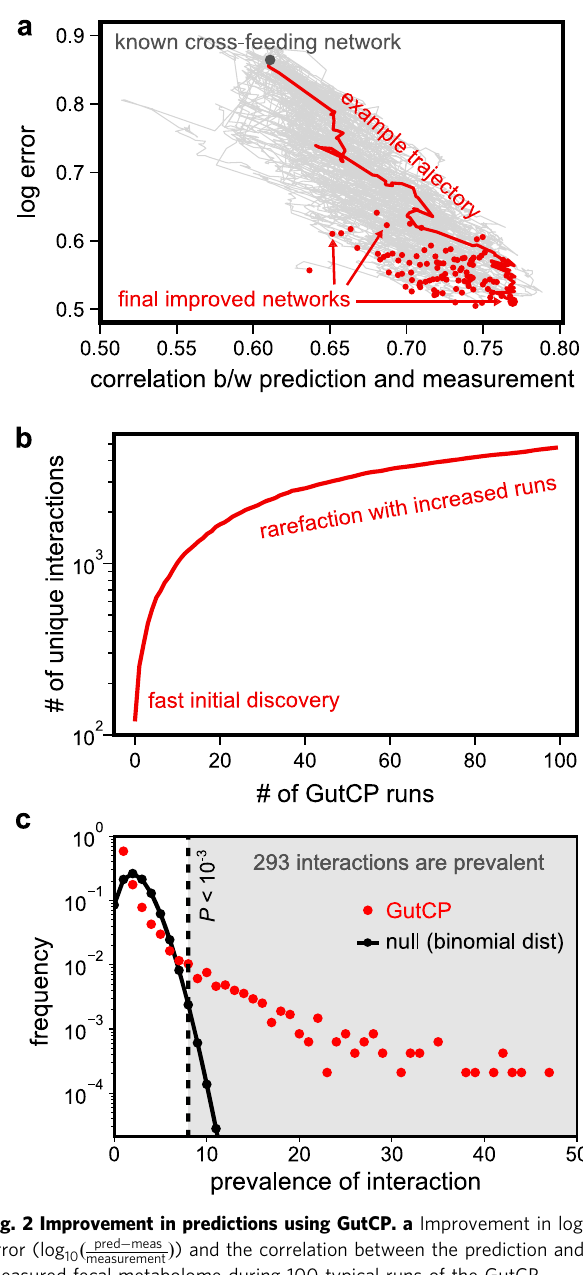
Fig. 2 Improvement in predictions using GutCP. a Improvement in log Þ ) and the correlation between the prediction and error (log 10 ð pred (cid:2) meas measurement measured fecal metabolome during 100 typical runs of the GutCP algorithm. The gray point at the top left indicates the performance of the original cross-feeding network of Ref. 9 , and the black points at the bottom right, that of improved networks predicted using GutCP. A trajectory example, highlighting how performance improves over a GutCP run, is shown in red, and others are shown in gray. b Rarefaction curve showing the number of unique cross-feeding interactions discovered by GutCP over 100 runs of the algorithm. c Prevalence of links, i.e., the number of GutCP runs in which they repeatedly appeared (red dots; total 100 runs) and for comparison, a corresponding binomial distribution with the same mean (black dotted line). P values for different prevalences are estimated using the one-sided binomial